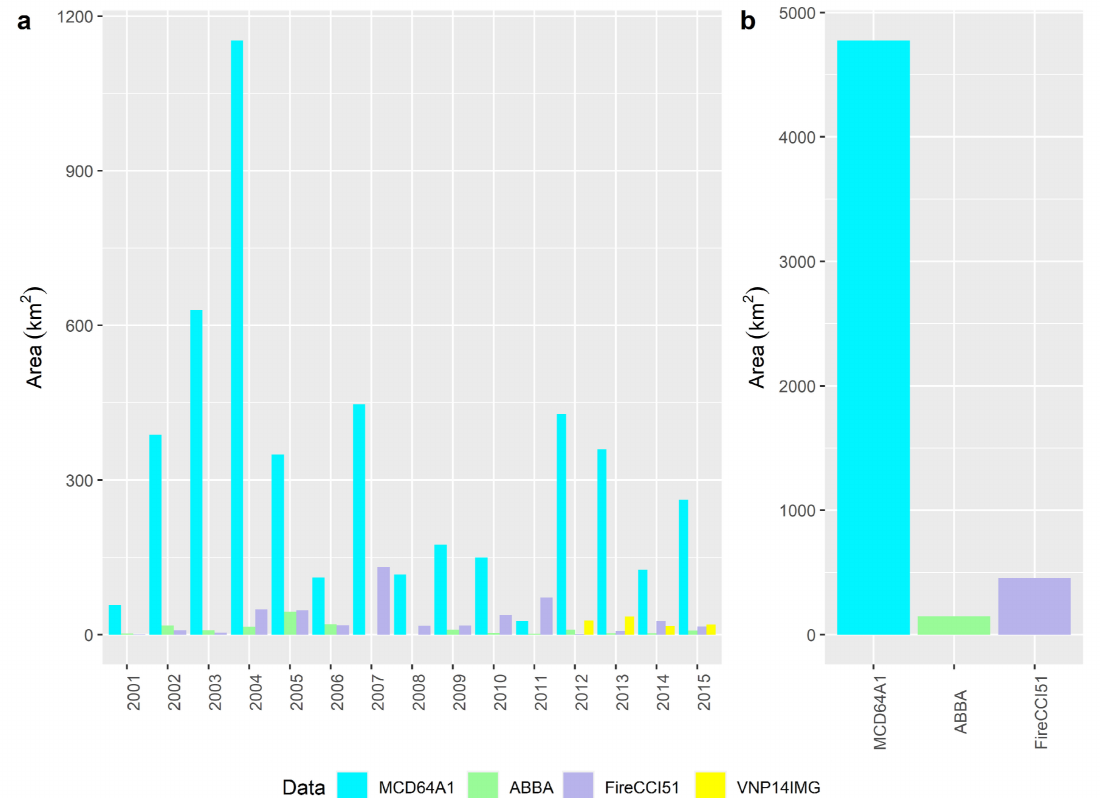
Figure 7. Comparisons of ( a ) annual total area and ( b ) grand total area of burned areas, as mapped by the MCD64A1, ABBA, FireCCI51 products, that are outside the buffer zones created based on the ALFD burned areas. In ( a ), the total area of 500 m pixels that have VNP14IMG active fire detections and outside the buffer zones is compared with the three burned area products as